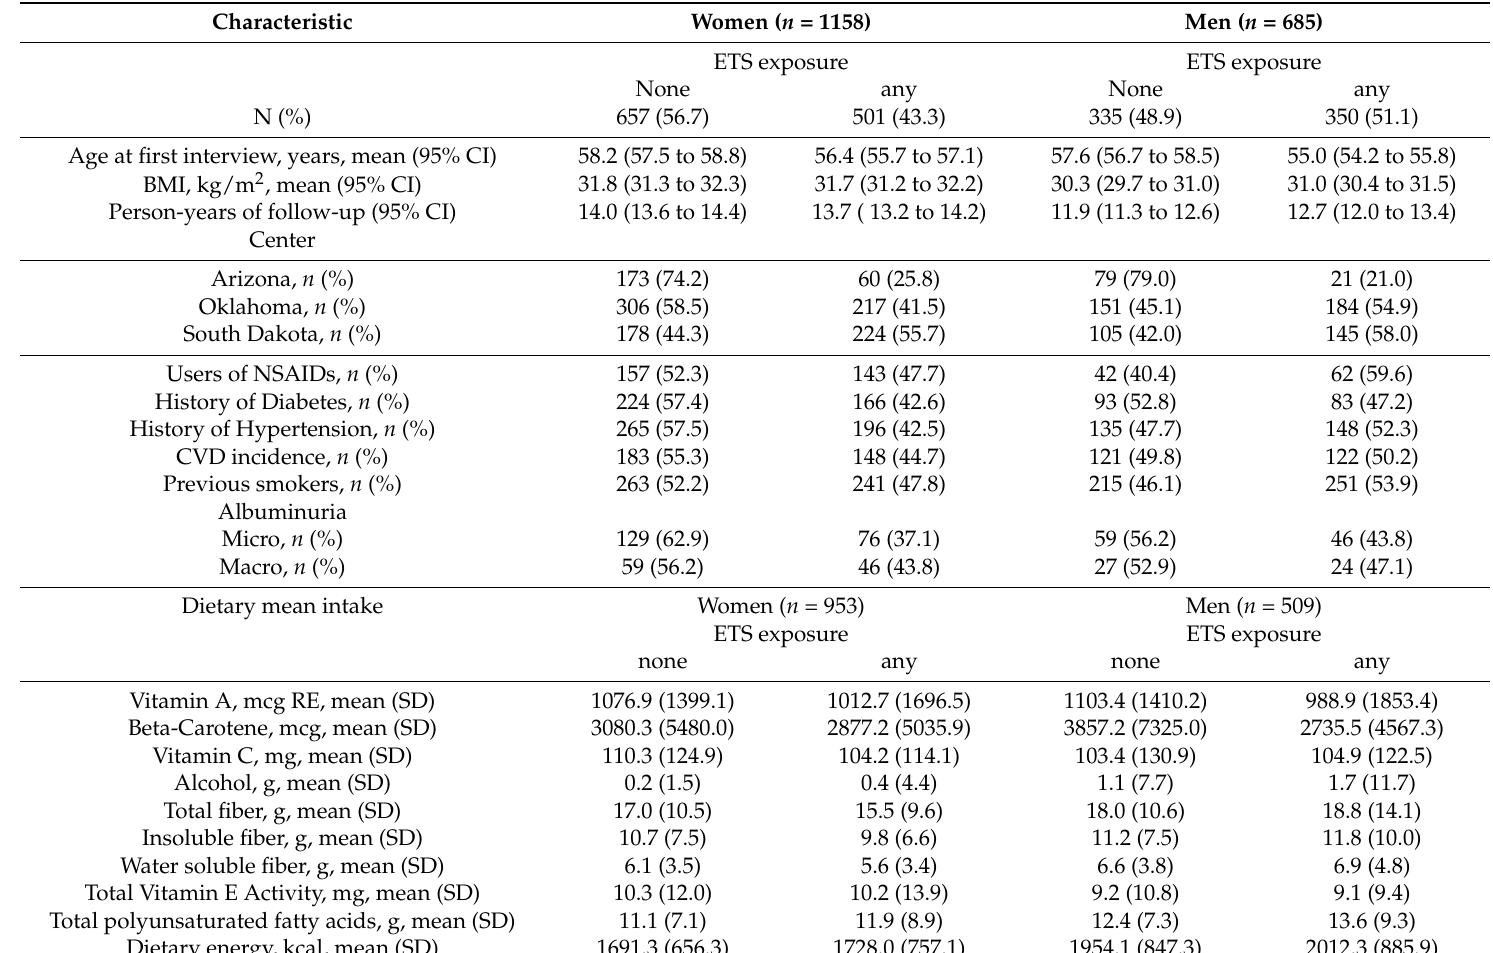
Table 1. Characteristics of Strong Heart Study nonsmokers ( n = 1843) by sex and exposure to Environmental tobacco smoke